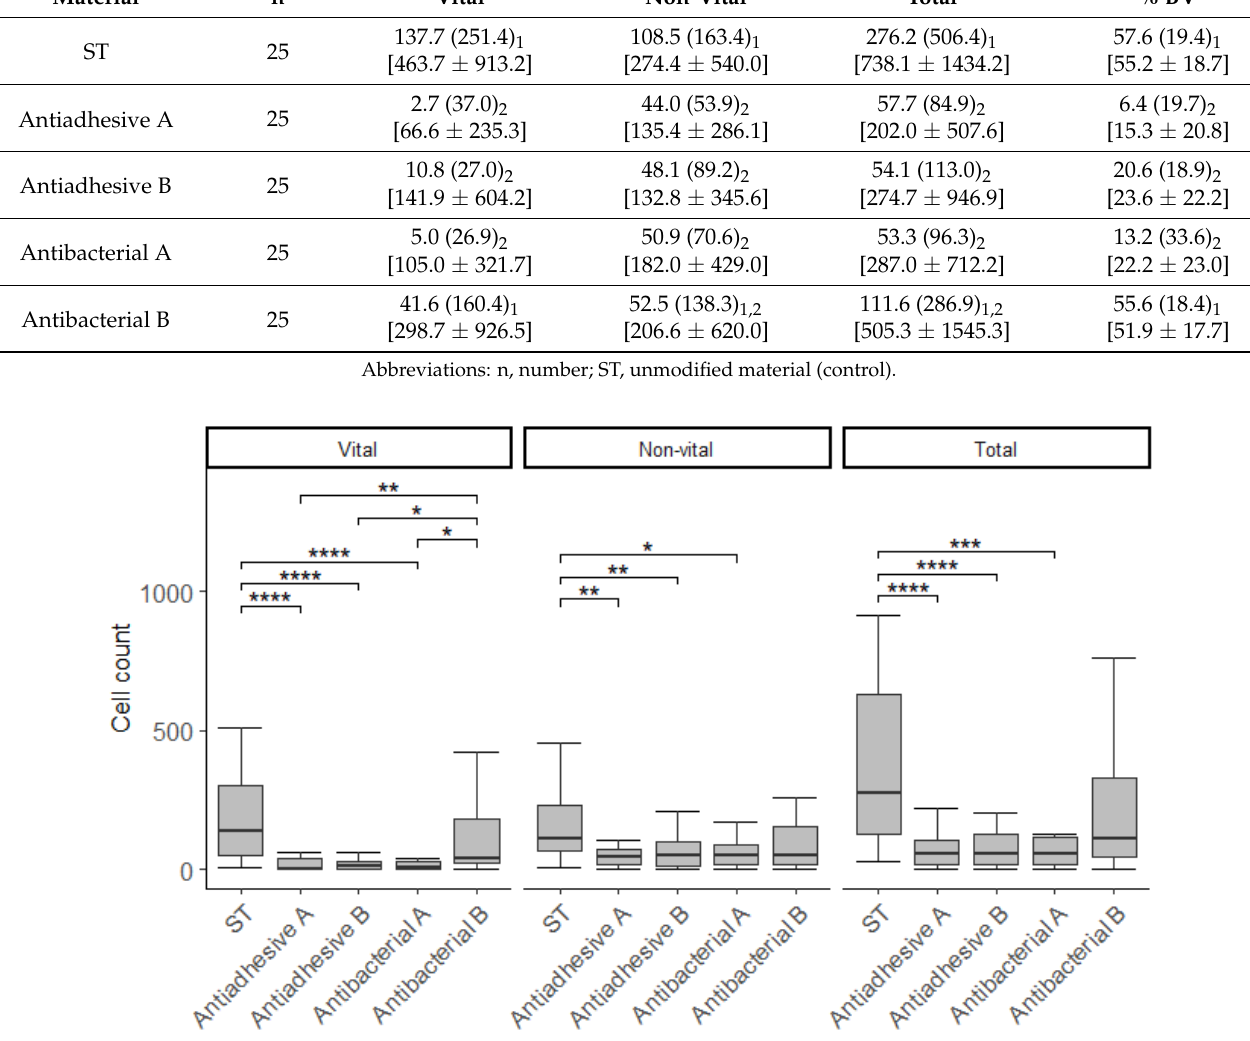
Figure 2. Tukey box plots of vital, non-vital, and total bacteria cell count without outliers. Significant differences are bracketed with asterisks (*, p < 0.05; **, p < 0.01; ***, p < 0.001; ****, p < 0.0001).